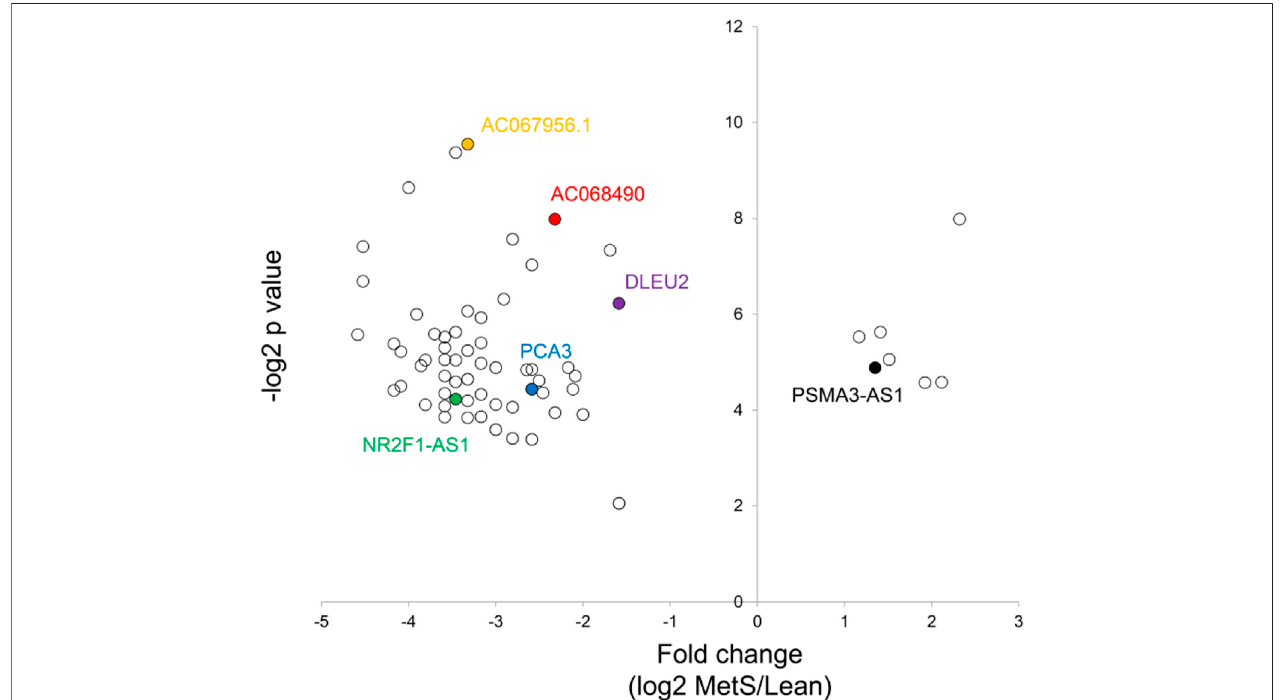
FIGURE 4 | Volcano plot of differentially expressed lncRNAs in circulating MetS-EVs versus Lean-EVs.